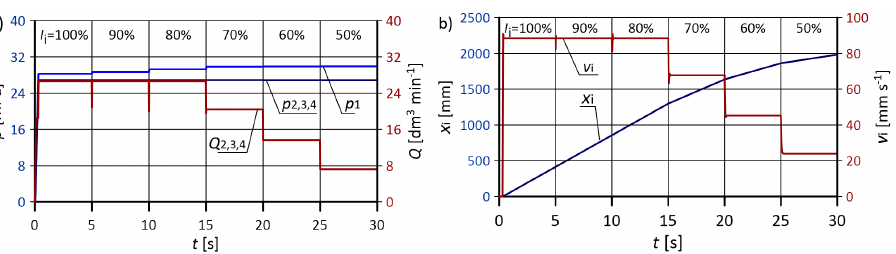
Figure 7. Results of the LSB system, equal load force F load , i = 15 kN; ( a ) pressures and flow rates, ( b ) speeds and positions of actuators.